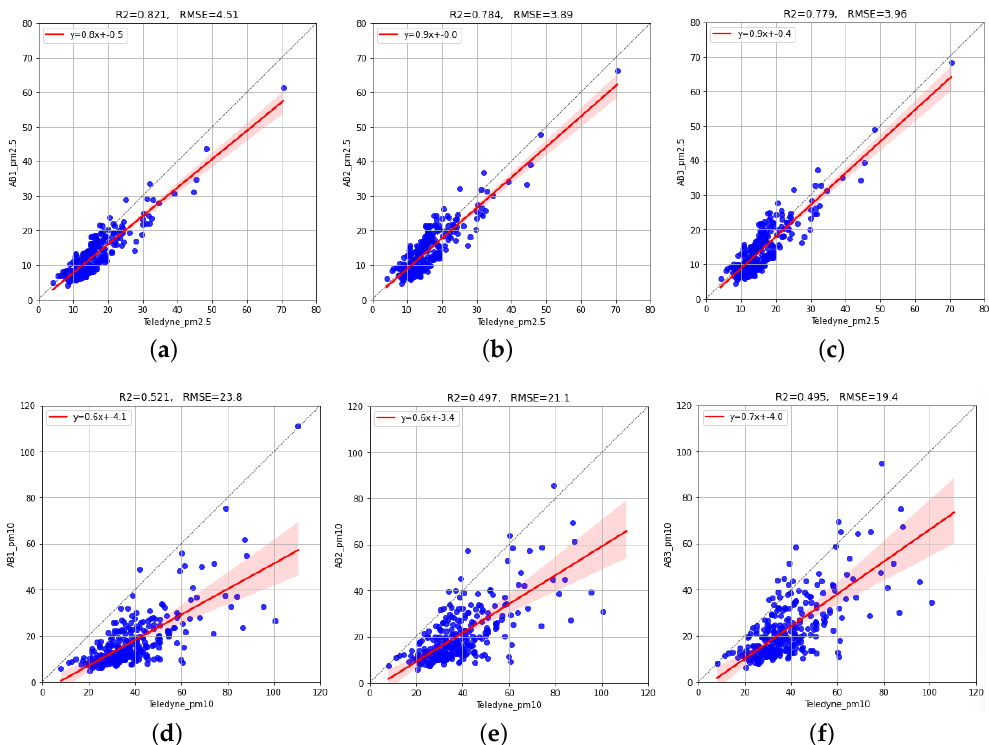
Figure 6. Scatterplots of the reference (Teledyne) vs. AirBeam sensor measurements in the Test period. The top row shows results for PM 2.5 sensors. The bottom row shows results for PM 10 sensors. The red line represents the linear regression function between candidate sensor values and reference sensor values adjusted with data from the Train period: ( a ) AB1 ( PM 2.5 ); ( b ) AB2 ( PM 2.5 ); ( c ) AB3 ( PM 2.5 ); ( d ) AB1 ( PM 10 ); ( e ) AB2 ( PM 10 ); ( f ) AB3 ( PM 10